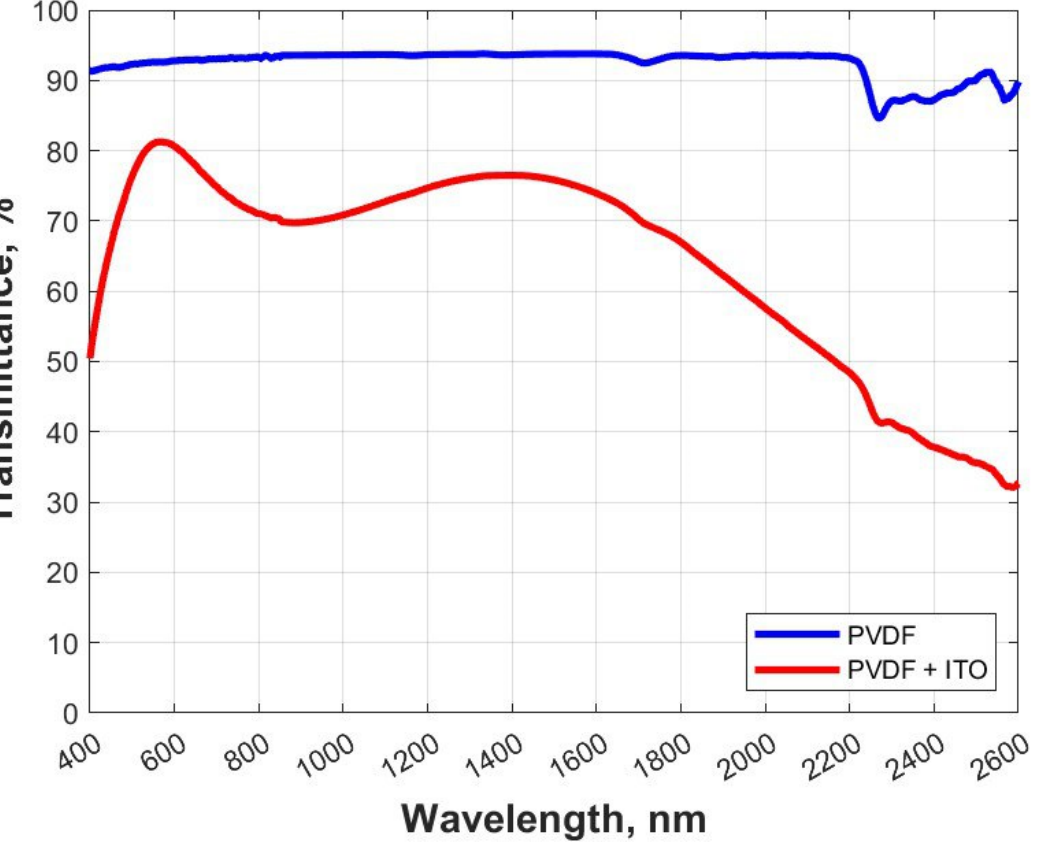
Table 4. Optical properties of experimental samples.